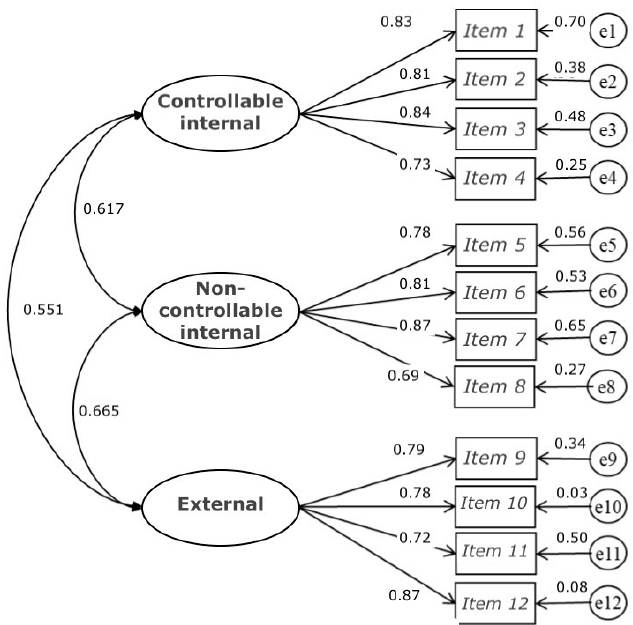
Figure 2. Model of three related factors of the Scale of Attributions of the Academic Failure.